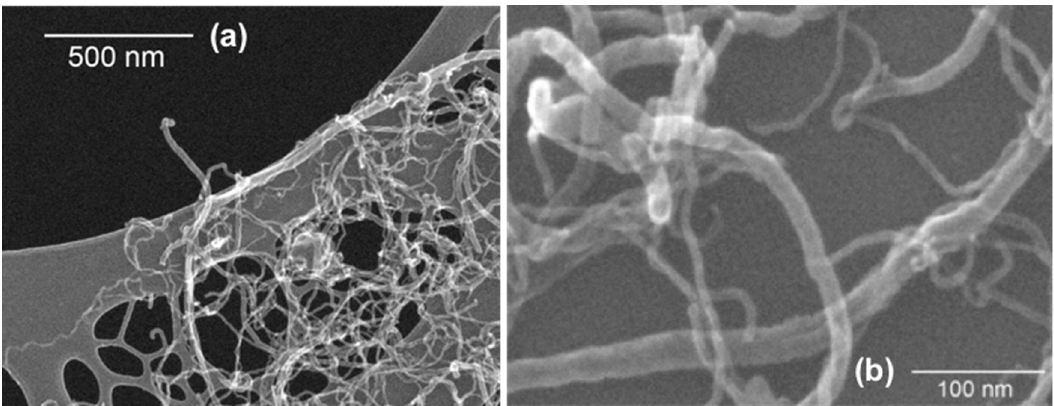
Figure 7. SEM images of 10% CNTs dispersion with TP9PYR(6) at different magnifications. ( a ) scale bar 500 nm; ( b ) scale bar 100 nm.